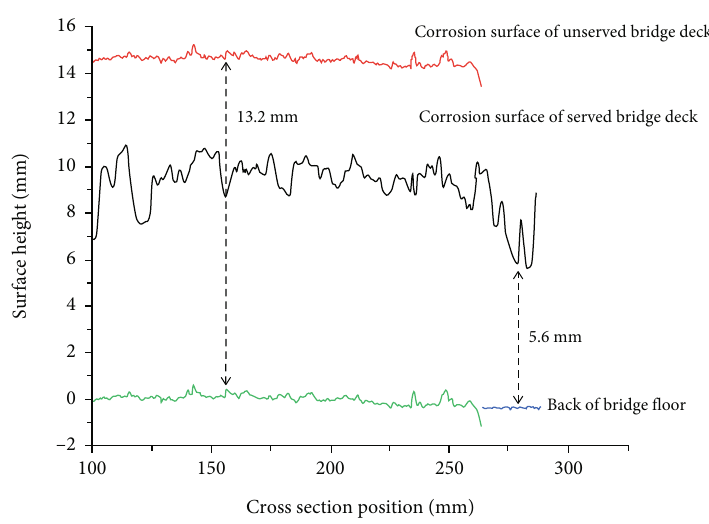
Figure 8: Comparison of corrosion height of bridge deck